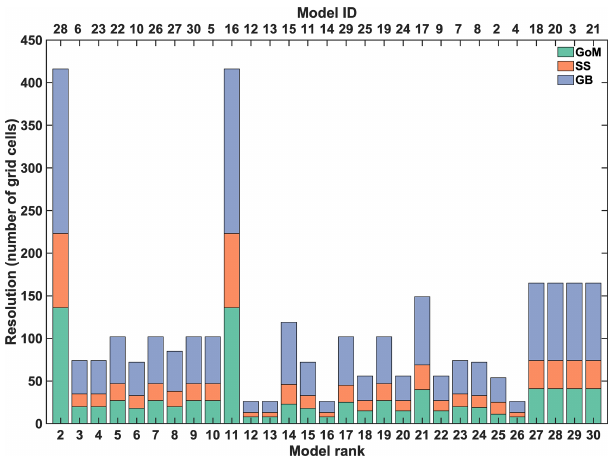
Figure 11. Resolution of the 29 ESMs ordered by their overall rank (see Fig.